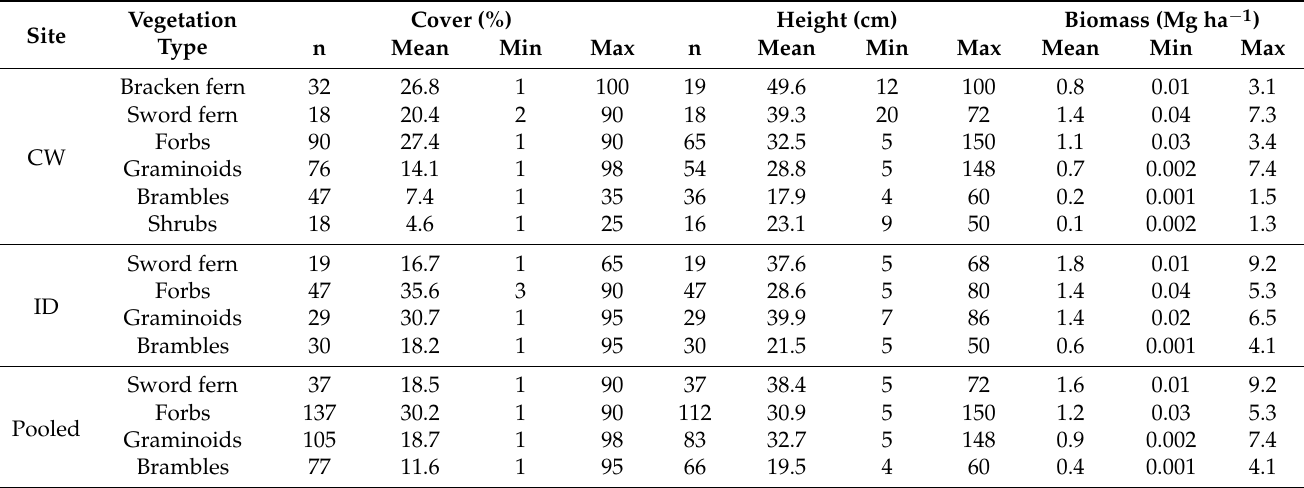
Table 2. Summary statistics of cover, height, and biomass measured by growth habit for the coastal wet (CW) and inland dry (ID) sites in western Oregon. Data from both sites were combined to create a pooled data set.